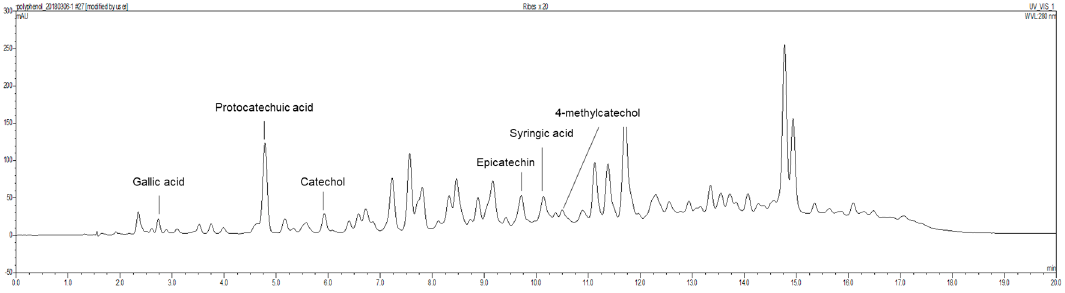
Figure 1. Chromatographic profile obtained with HPLC in ethyl acetate extract of Ribes diacanthum Pall.